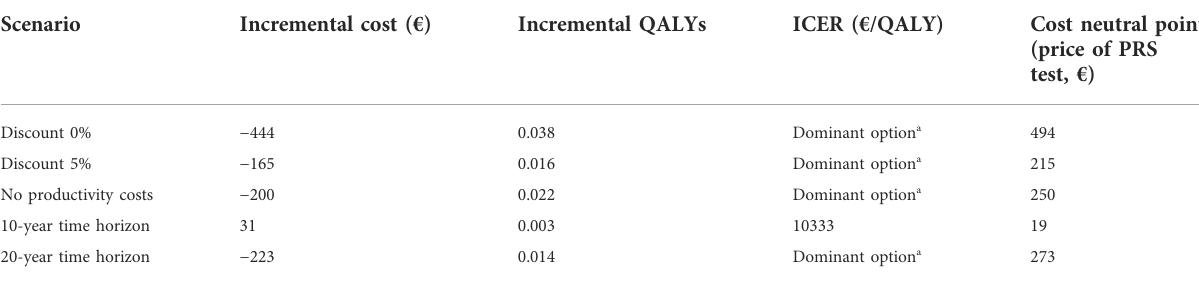
TABLE 5 Results from sensitivity